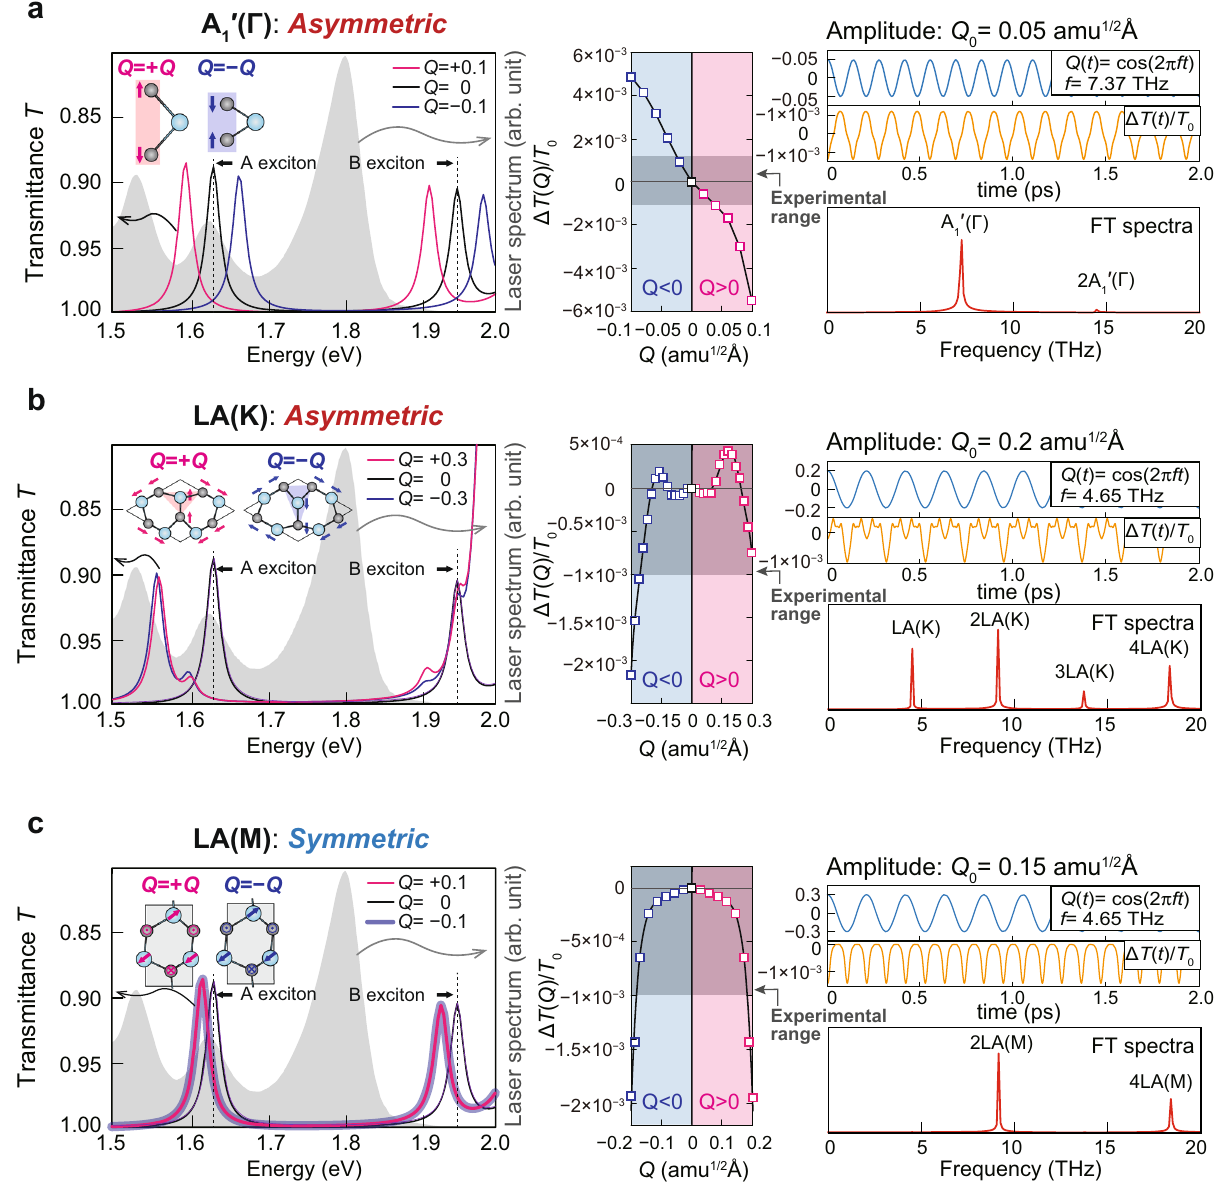
Fig. 3 | Calculated transmittance spectra of monolayer MoSe 2 modulated by lattice deformations and derived opticalmodulations. The optical modulations are induced by: a A 1 ′ ( Γ ), b LA(K), and c LA(M) modes. Left panel: transmittance spectra of monolayer MoSe 2 with and without the lattice deformations ( Q =±0.1, ±0.3, and 0, respectively) and the laser spectrum (gray shading) used in the